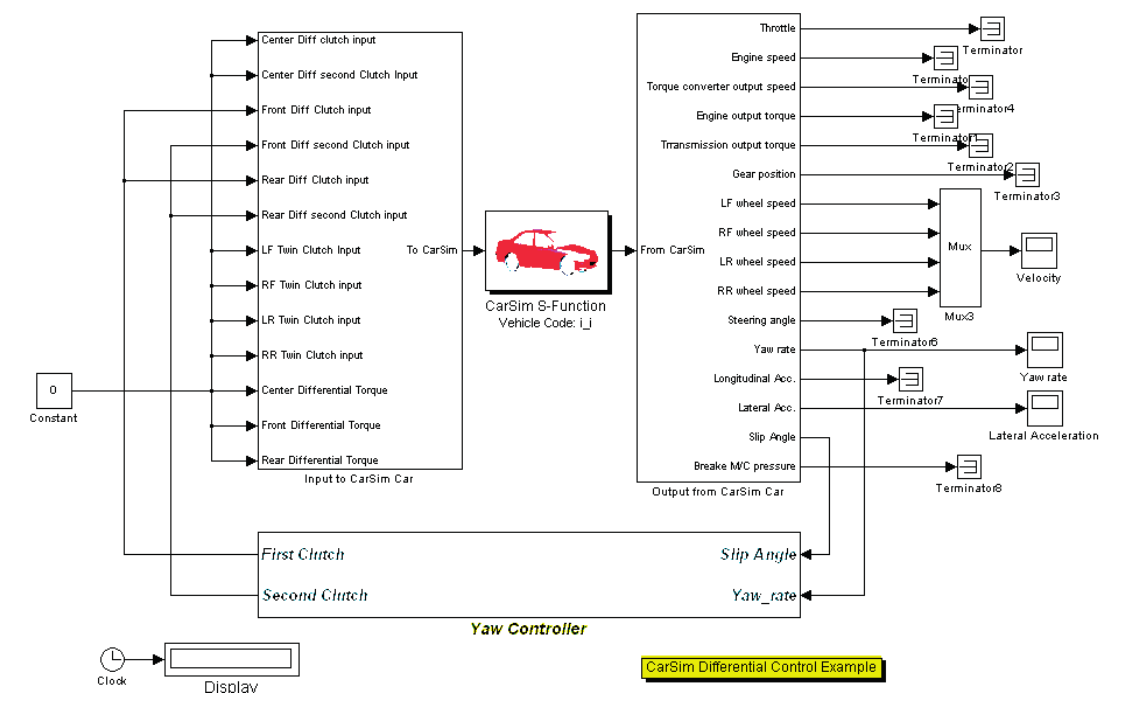
Figure 7. Simulink diagram.